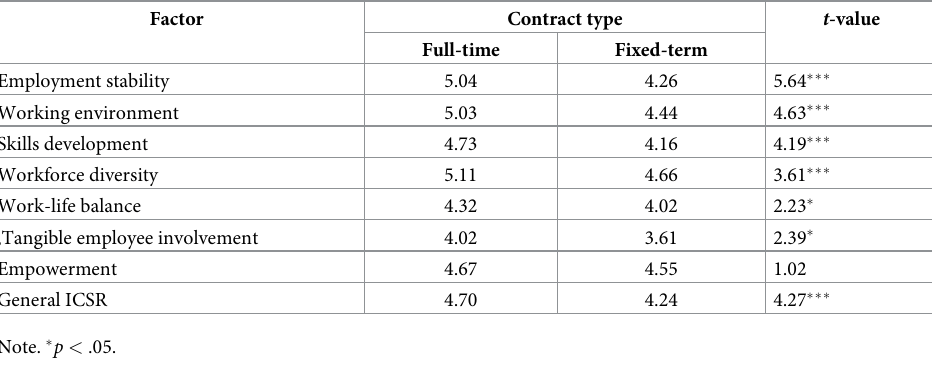
Table 3. Means of ICSR across contract type.